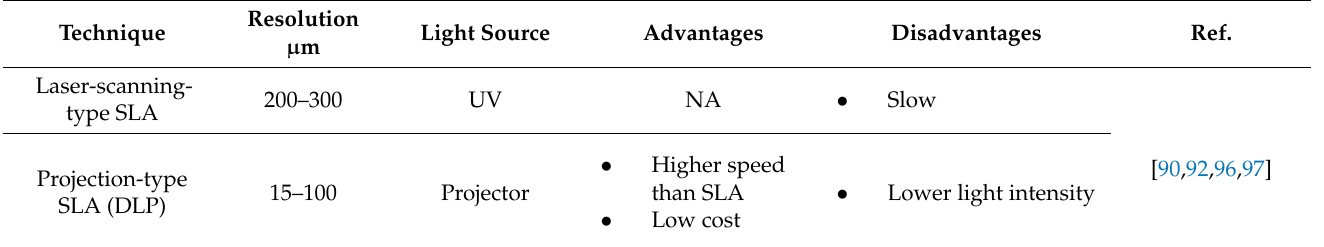
Table 3. Comparison between laser-scanning-type SLA and projection-type SLA (DLP) 3D